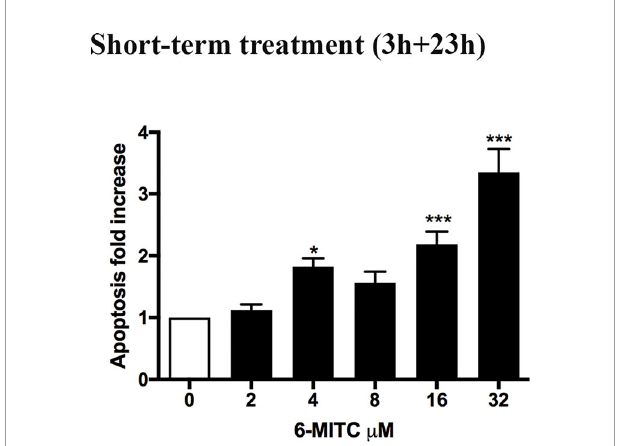
FIGURE 3 | Effect of 6-MITC on apoptosis after short term treatment. Apoptosis fold increase in TK6 cells treated with 6-MITC for 3h followed by 23h of recovery in complete medium. Each bar represents the mean ± SEM of fi ve independent experiments. Data were analysed using repeated ANOVA followed by Dunnet post-test. *p < 0.05 vs 0; ***p < 0.001 vs